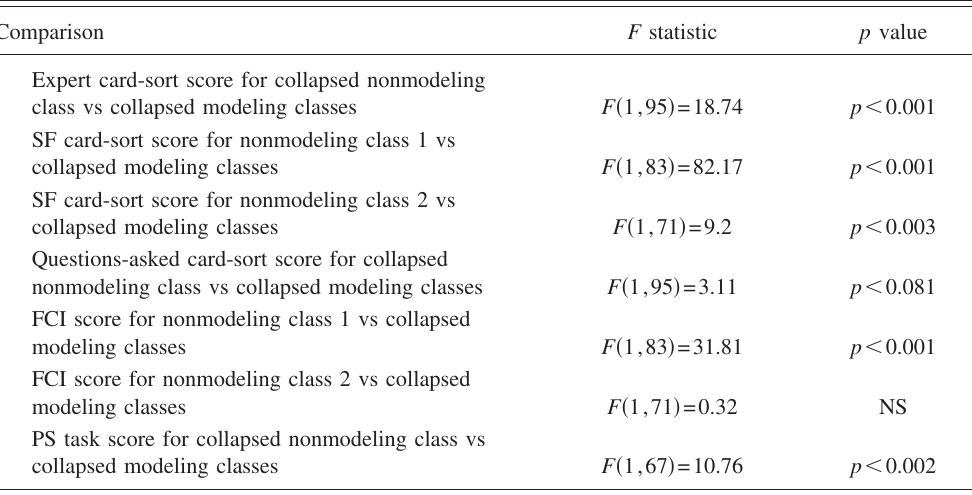
TABLE II. Summary of ANOVA results between modeling and nonmodeling class post-test scores. Scores that are statistically significant are shaded. NS stands for